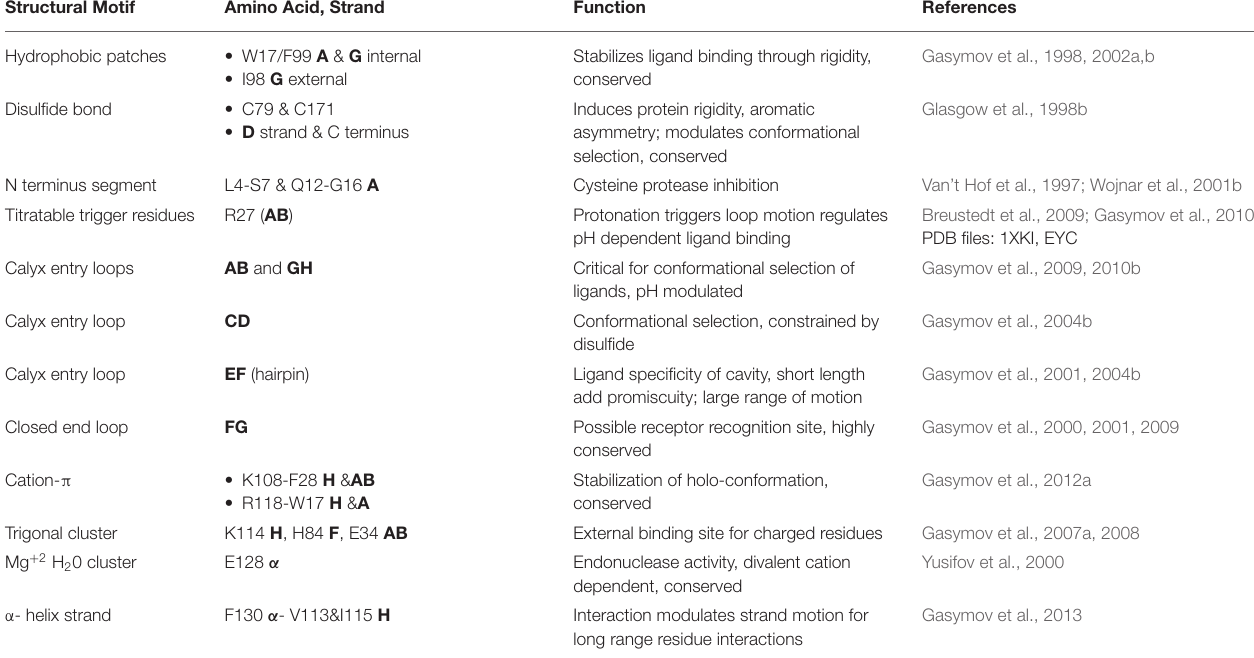
TABLE 4 | Structure-function of critical motifs of tear